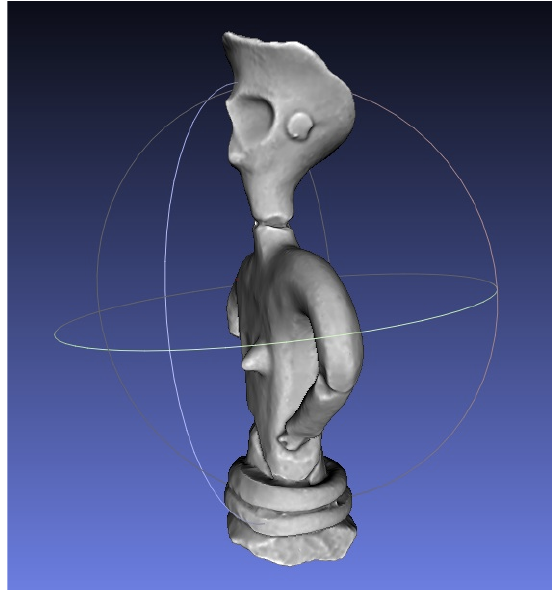
Figure 9: Still from the digital model of a female figurine from Prinias (HN 5932).